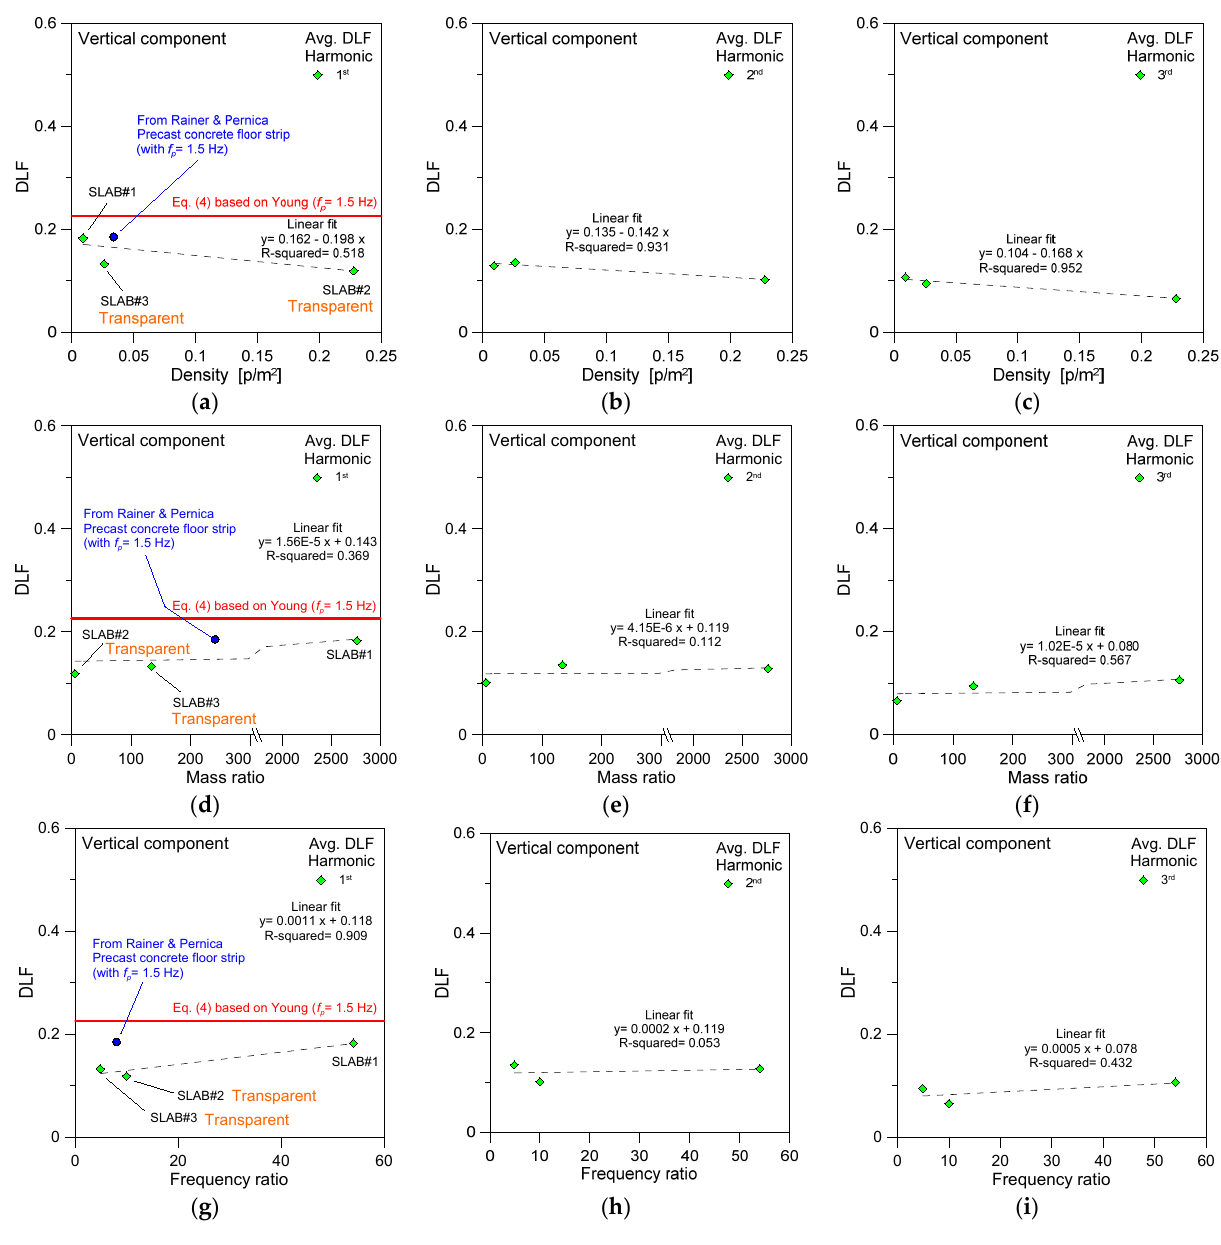
Figure 11. Correlation by linear regression model of experimentally derived DLF trends (average), as a function of harmonic order, with evidence of results for vertical force components based on body CoM measurements. Comparisons are proposed towards Rainer & Pernica [7] and Young [29]. Linear fits are proposed in terms of ( a – c ) occupation density of selected slabs #1, #2, #3, ( d – f ) mass ratio, or ( g – i ) frequency ratio. Average DLF values calculated for a single adult pedestrian, based on eight walking records for SLAB#1, 10 for #2 and nine for #3.